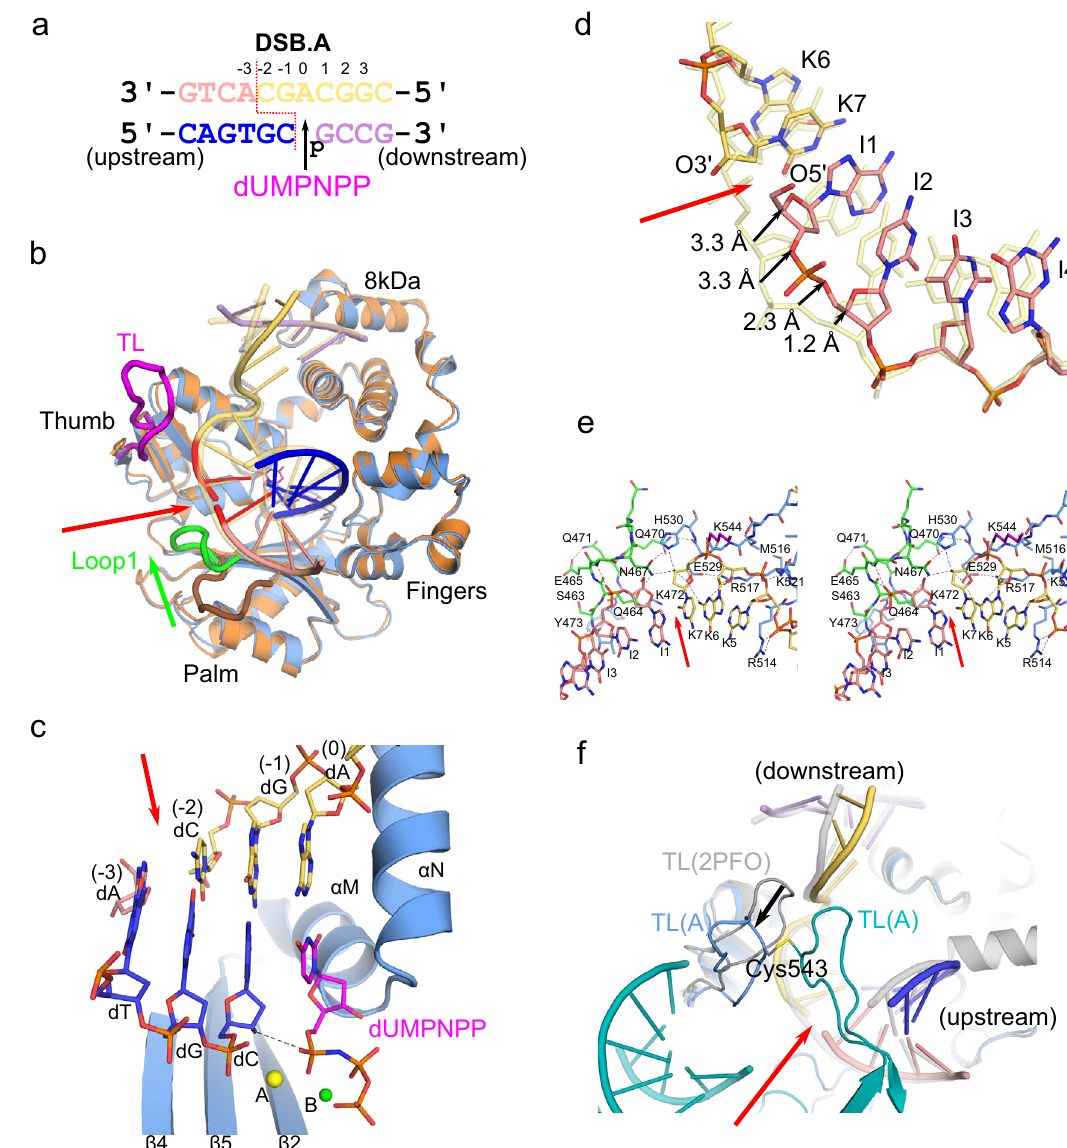
Fig. 5 Pol λ in complex with entirely complementary DSB.A. a Complementary DSB.A substrate (template strand broken between the − 2 and − 3 positions) co-crystallized with the Pol λ catalytic domain (molecule B). The break site is indicated by a red dashed line. Upstream (left) template (pink, chain I) and primer (blue, chain J) are annealed separately from the downstream (right) template (pale orange, chain K) and primer (lavender, chain L) strands, and synapsis is mediated entirely by the polymerase. The DSB.A pre-catalytic quaternary complex is formed by addition of the nonhydrolyzable incoming dUMPNPP (magenta) nucleotide. b Global superposition of the pre-catalytic SSB ternary (orange) and complementary DSB.A quaternary (protein in blue, DNA and incoming dUMPNPP colored as in a ) complexes. Positional differences of Loop1 (green), the thumb loop (TL, magenta), and the DNA template strand between the DSB.A and SSB structures are highlighted. Break site is indicated by a red arrow. c Structure of the DSB.A substrate bound in the Pol λ active site (protein in light blue; DNA and incoming nucleotide drawn in stick and colored as in a ). The Na + and Mg 2 + ions are shown as yellow and green spheres, respectively. The path between the primer terminal 3 ′ -OH (axial) and the α -phosphate of the incoming dUMPNPP is shown (black dashed line). d Zoomed-in view of template strand shift in DSB.A (colored as in a ), superimposed with the SSB (transparent khaki). e Stereo diagram of the interactions surrounding the break site (red arrow) in the DNA template strand (protein in light blue, DNA colored as in a ), with hydrogen bonding interactions shown (black dashed lines). Residues from Loop1 and the ‘ thumb loop ’ are colored green and magenta, respectively. f Thumb loop in 7M0D (Ala535-Gly548) is ordered and differs in conformation from that observed in 2PFO 18 (gray). Thumb loop conformation may be in fl uenced by crystal packing interactions, as the thumb loop in molecule A (teal) interacts with the end of the upstream duplex from molecule B (colored as in a ), and vice versa. The disul fi de bond between Cys543 in each loop is between β -strands 7 and 8 in the thumb subdomain (Fig. 5b, that observed in other previously reported structures (PDB ID magenta). The ‘ thumb loop ’ is often disordered in Pol λ structures, code 2PFO 18 , Fig. 5f, gray). Within the current lattice, the two ‘ thumb loops ’ are in close contact — mediated by a disul fi de bond but is ordered in both molecules within the asymmetric unit of between the Cys543 sidechains — and interact with the DNA the DSB.A pre-catalytic quaternary complex and adopts the same substrate. conformation in each (Supplementary Fig 3b), which differs from